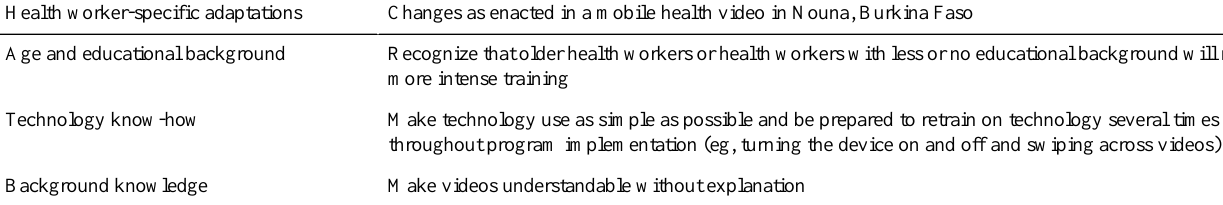
Make videos understandable without explanationBackground knowledge